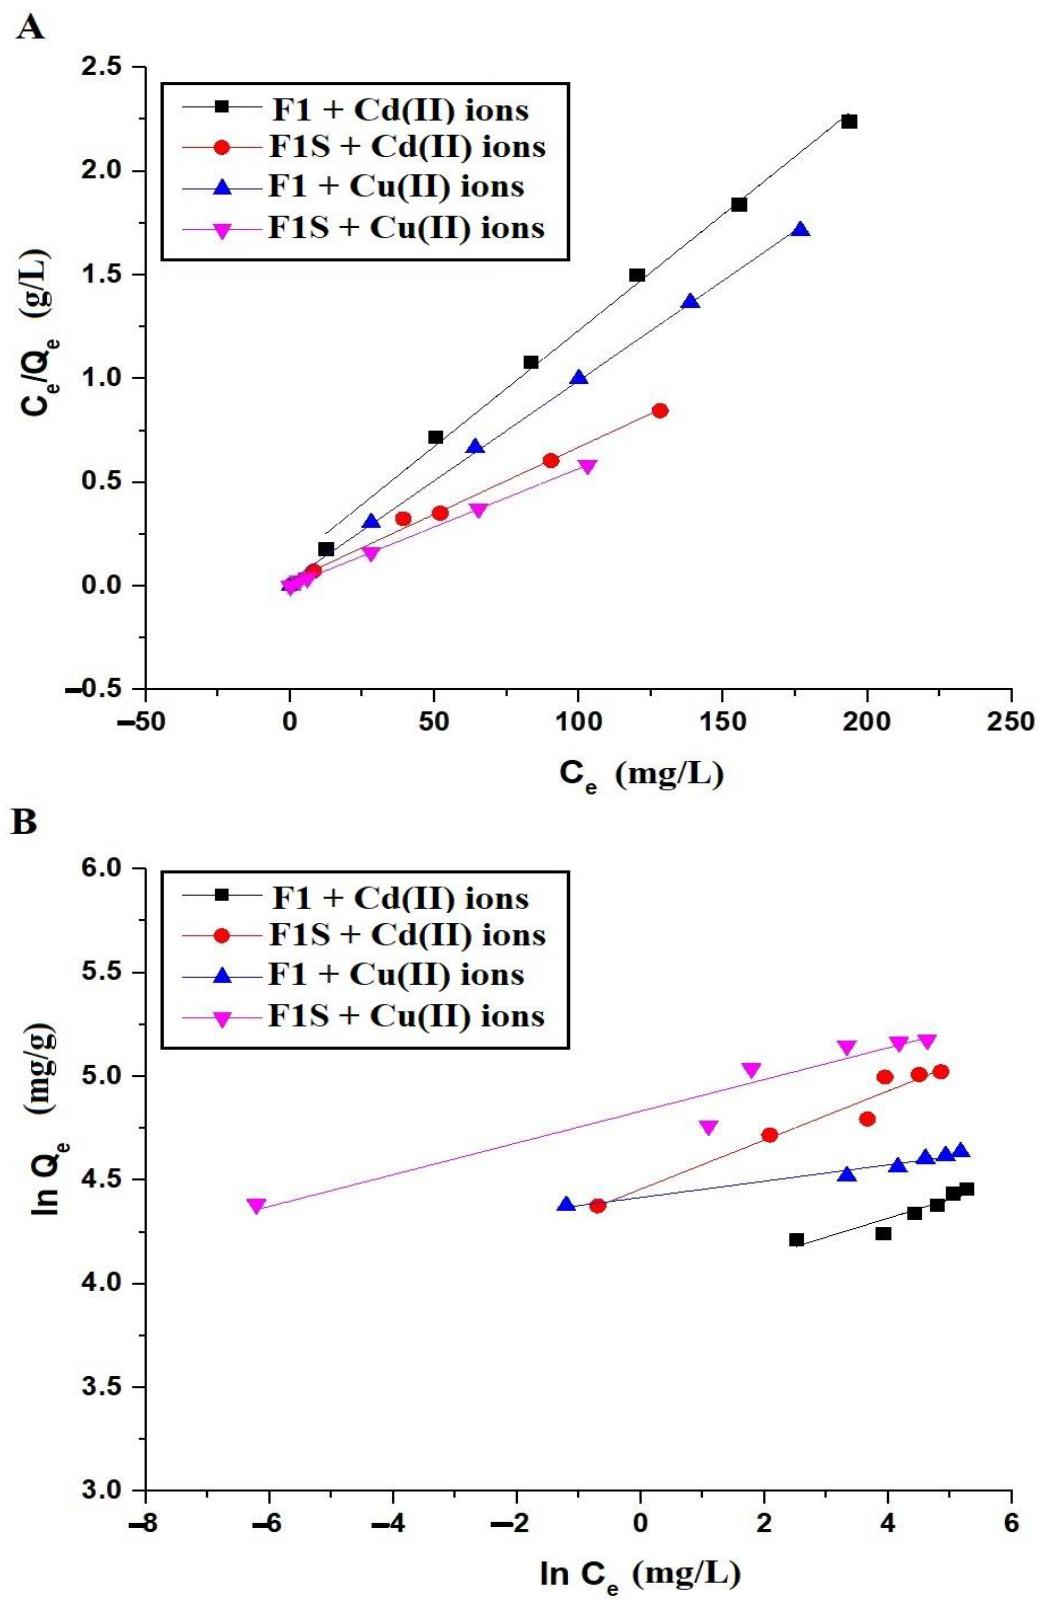
Figure 12. The Langmuir ( A ) and Freundlich ( B ) equilibrium isotherms for the removal of cadmium and copper ions using the F1 and F1S samples.